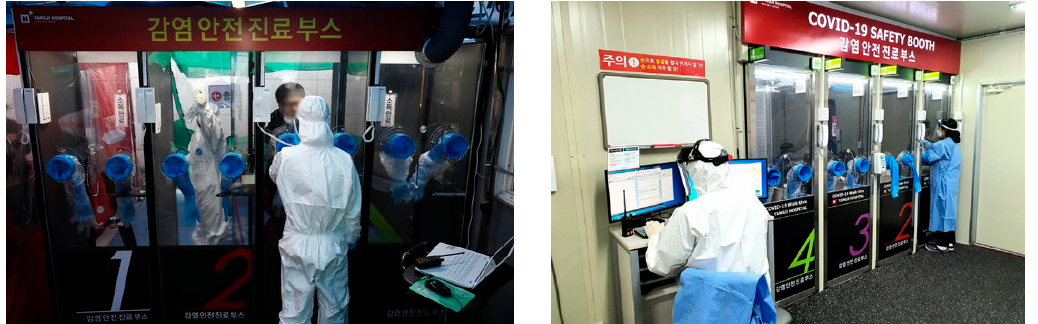
Figure 4. Drive-through centres for COVID-19.